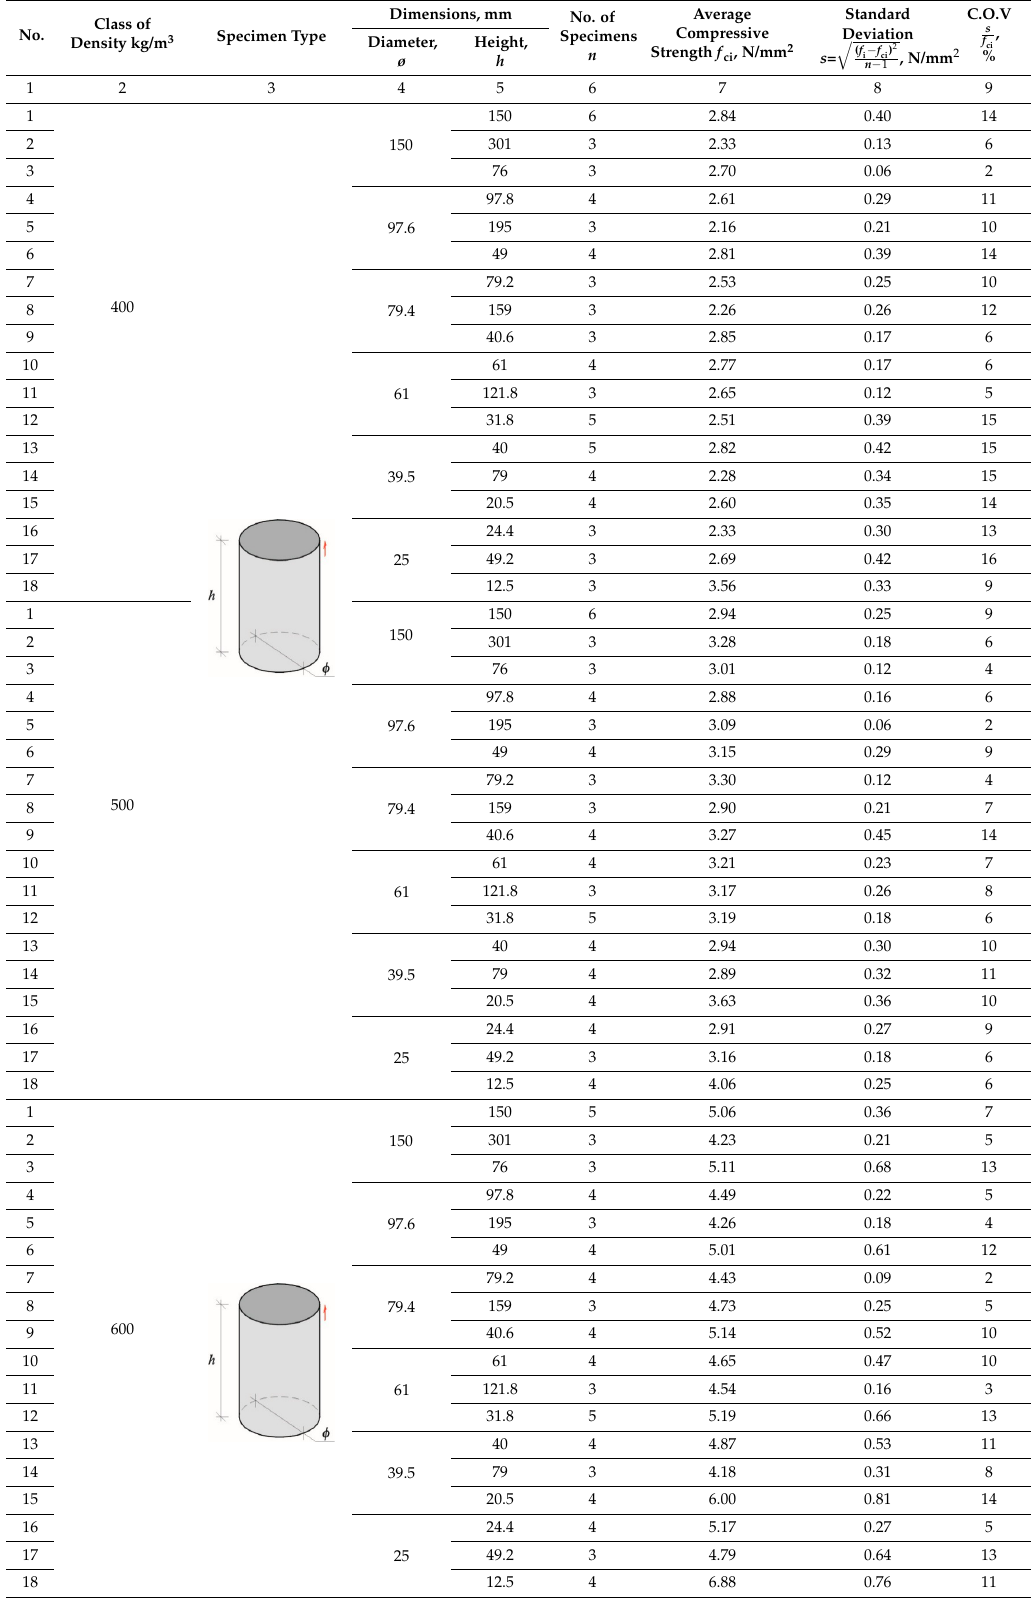
Table 1. Results from compressive tests performed on core (cylindrical) specimens.